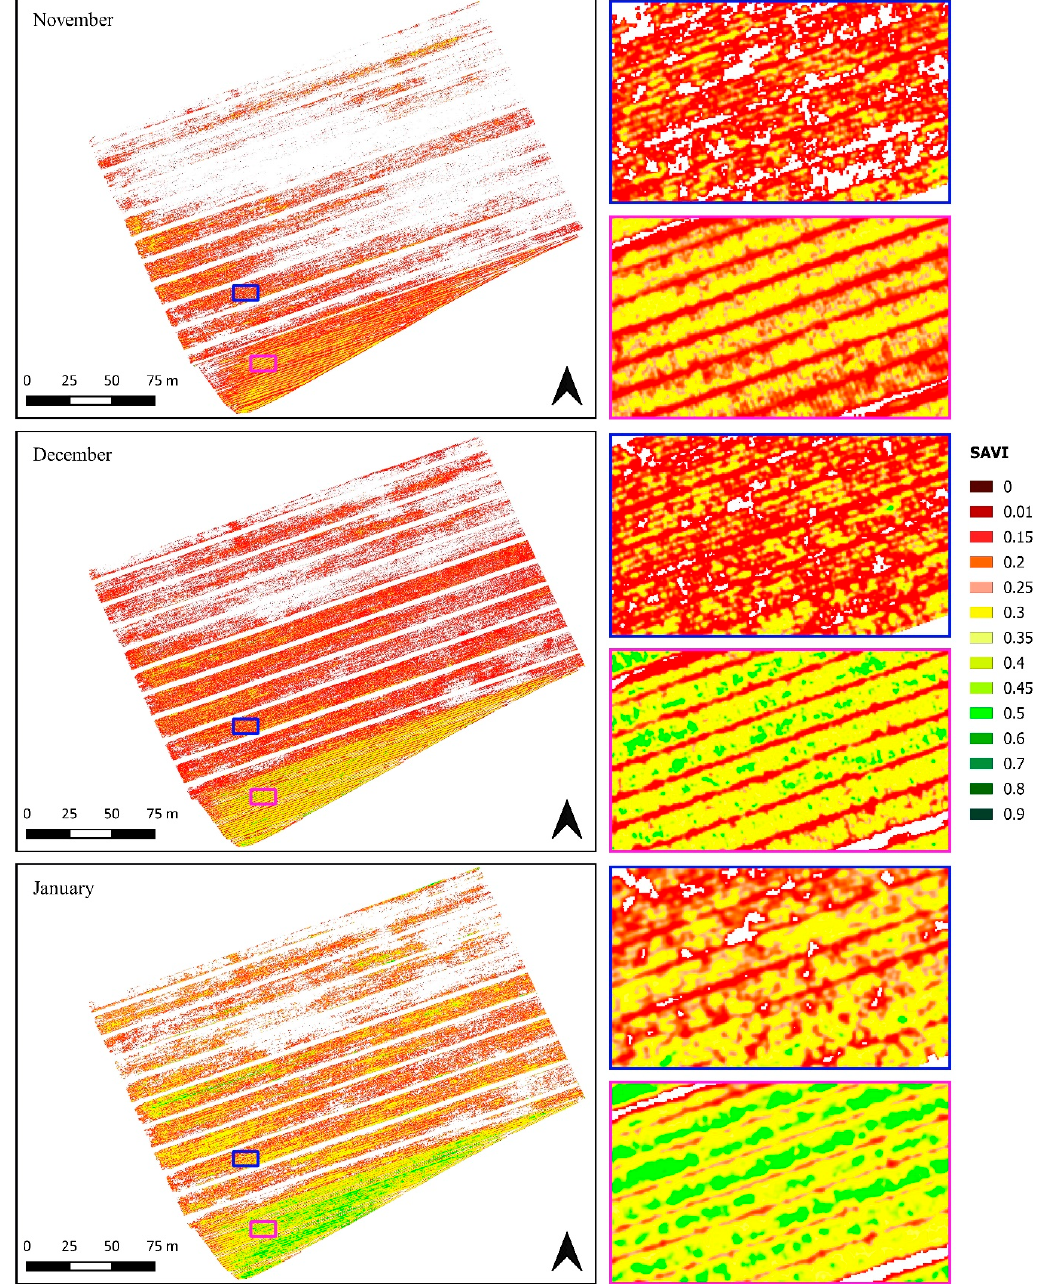
Figure 13. SAVI maps from November 2018 ( top ) to January 2019 ( bottom ). Next to the image of each dataset, blue and magenta rectangles magnify the details of the vegetative vigor of onion crops in two different parts of the field and where the transplanting took place with three weeks apart. The ellipses highlight areas of the field where the onion crops showed a low vegetative vigor.